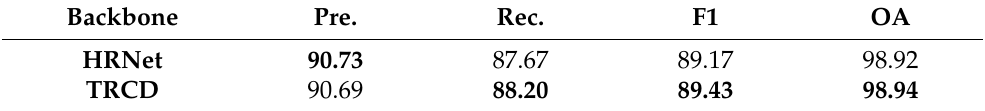
Table 10. Quantitative results of improved framework on LEVIR-CD with 2048 pairs of images. Backbone Pre. Rec. F1 OA HRNet